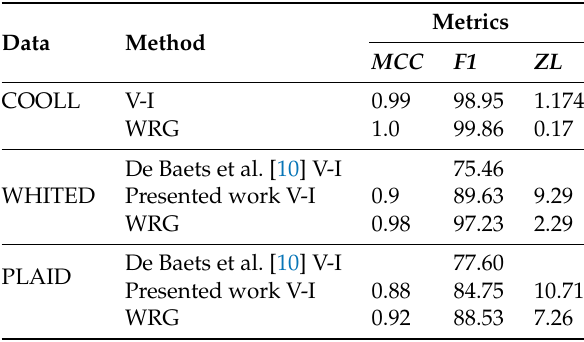
Table 3. Generalisation performance between WRG and VI on PLAID, COOLL and WHITED